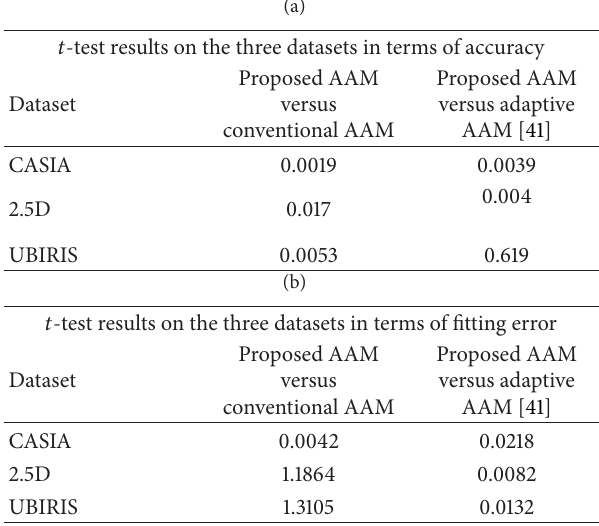
Table 14: 𝑡 -test values of proposed AAM versus conventional AAM and proposed AAM versus adaptive AAM.